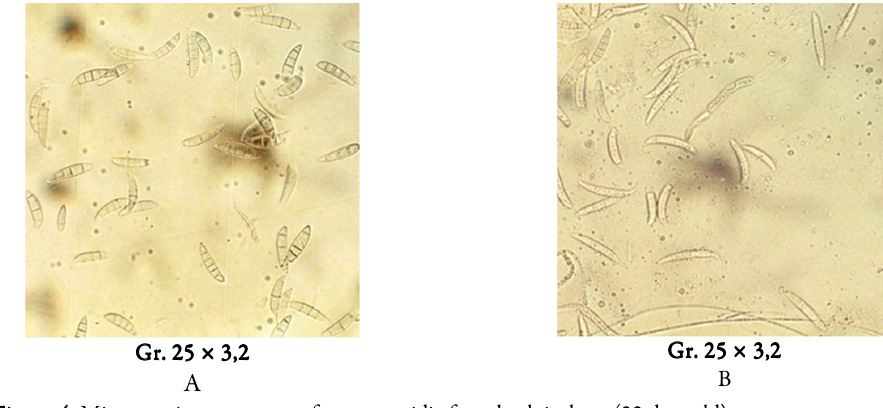
Figure 4. Microscopic appearance of macroconidia from both isolates (22 days